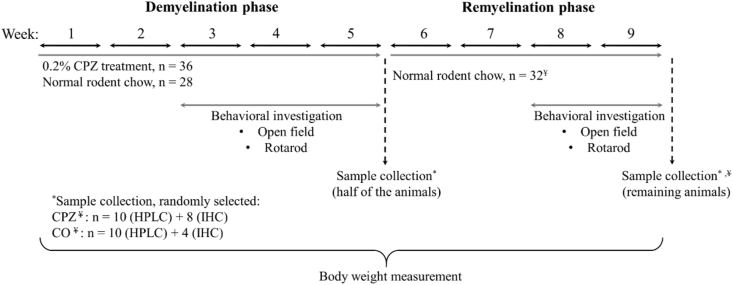
Timeline of the experimental procedure applied in this study. CPZ cuprizone; CO control; IHC immunohistochemical studies; HPLC High-performance liquid chromatography; ¥One animal died in cage at the beginning of the remyelination phase in the CPZ treated group and at the end of the remyelination phase, an animal also died in the CO group before perfusion. n represents the number of animals used in one group. ∗Sample collection was randomly selected in the CPZ treated- and the CO group.